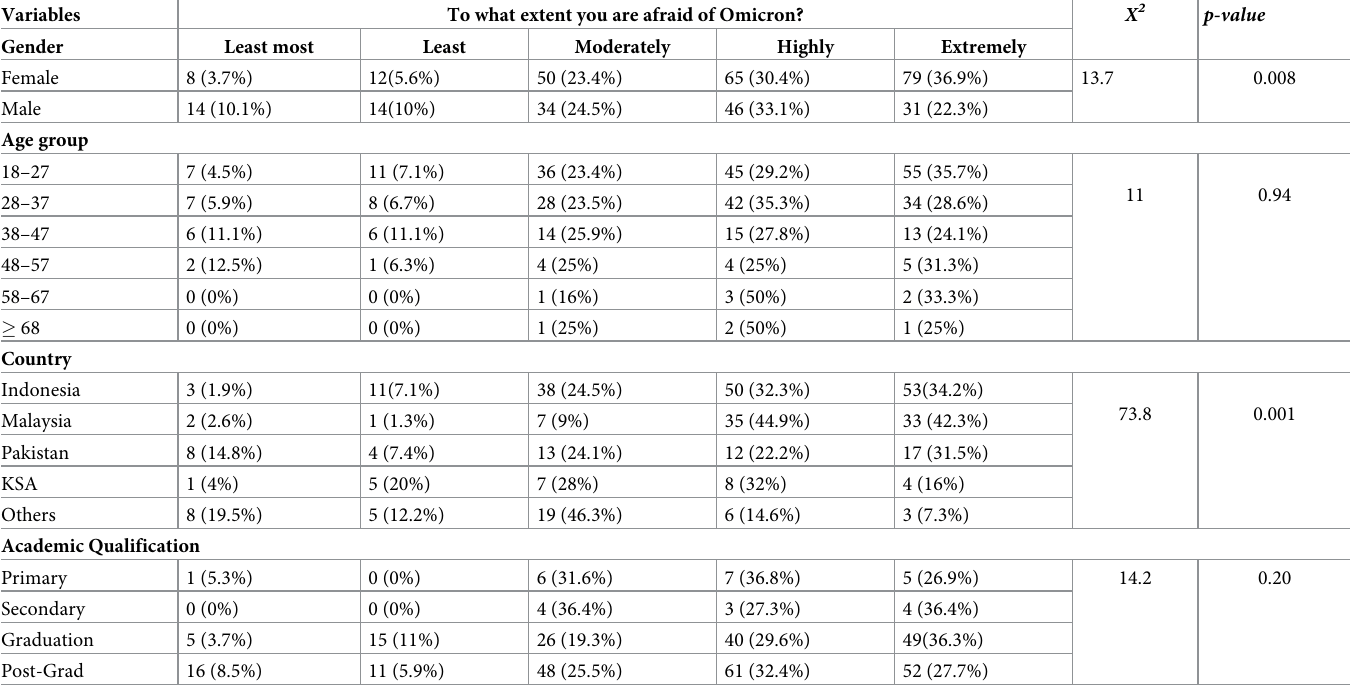
Table 11. Levels of fear towards